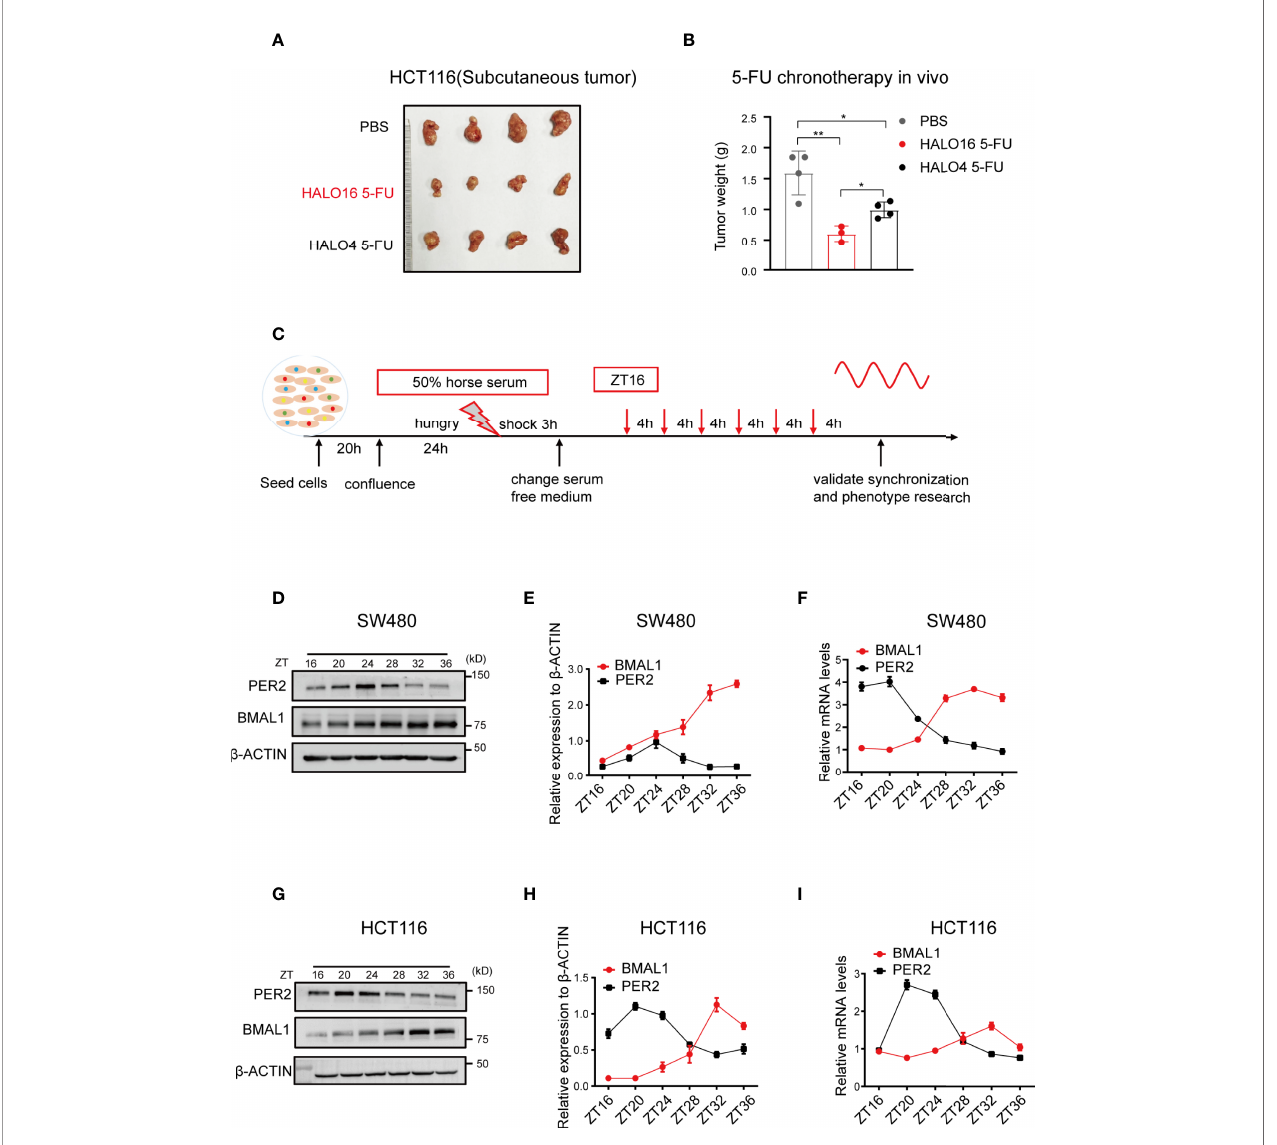
FIGURE 1 | The therapeutic ef fi cacy of 5-FU in CRC are rhythmic in vivo. ( A, B ) HCT116 cells were subcutaneously injected into mice to observe 5-FU chronochemotherapy in cohort 1. One week after cell inoculation, the mice were treated with 5-FU (30 mg kg -1 , twice a week) or PBS at the indicated time points for four weeks. (n = 4 unpaired t test). (C) Schematic diagram for resetting the circadian oscillations in cultured cells by horse serum. Cells were collected every 4 h for a total of 24 h at the indicated time points. ZT, zeitgeber time (literally, time given or time cue) refers to environmental variables that act as circadian time cues. (D – F) The expression of BMAL1 and PER2 at the indicated time points in SW480 cells after synchronization using Western blotting and qPCR (n = 3). (G – I) The expression of BMAL1 and PER2 at the indicated time points in HCT116 cells after synchronization using Western blotting and qPCR (n =